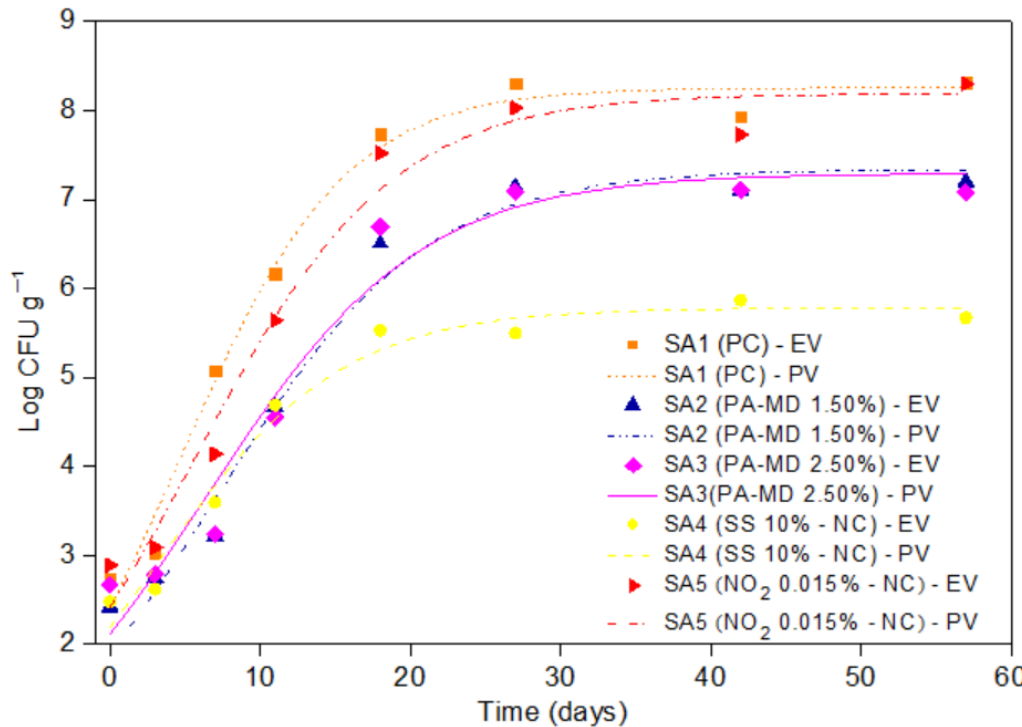
Figure 5. Clostridium perfringens growth curve in cooked sausage (SA) formulations that have been adjusted to the logistic model (LM). PA-MD: phytic acid-maltodextrin; SS: sodium sorbate; NO 2 : sodium nitrite; PC: positive control; NC: negative control; EV: experimental values; PV: predicted values by LM.